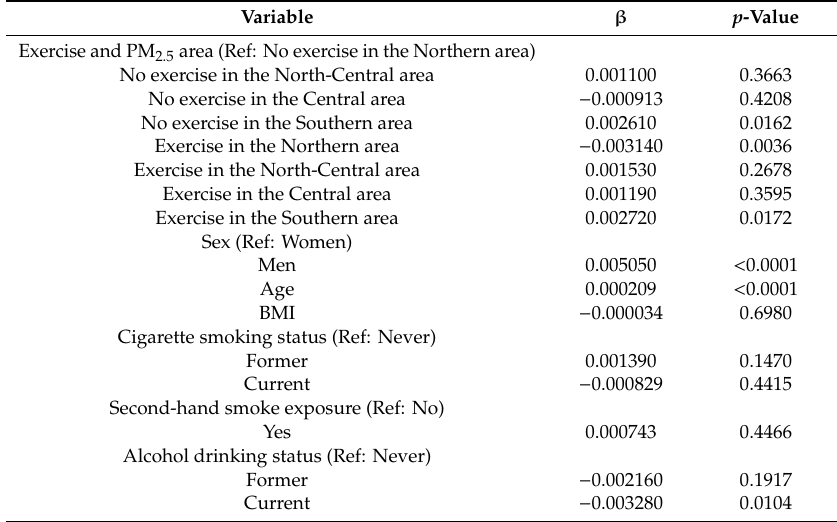
Table 4. Association of exercise habits and residential area with SOX2-promoter methylation in